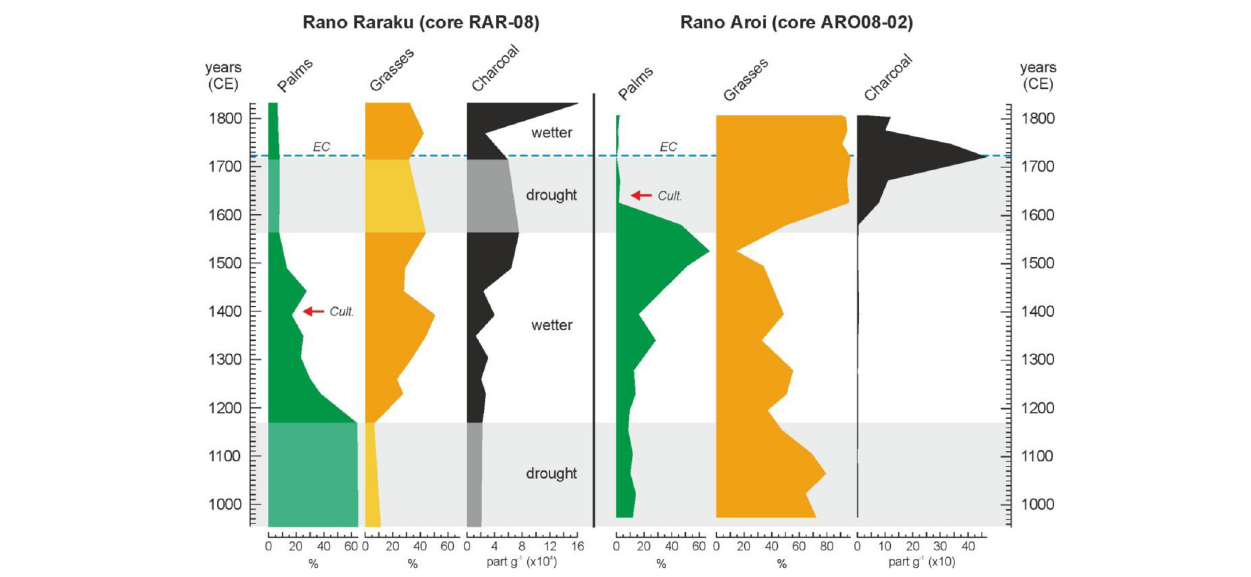
FIGURE 6 | Summary pollen diagrams of Raraku and Aroi continuous sequences for the last millennia. Redrawn from Cañellas-Boltà et al. (2013) and Rull et al. (2015). In Raraku, light-colored areas indicate the sedimentary gaps with no pollen data. Red arrows indicate the first evidence of cultivation according to Horrocks et al. (2012a, 2015). The European contact (EC) is indicated by a dotted blue line.